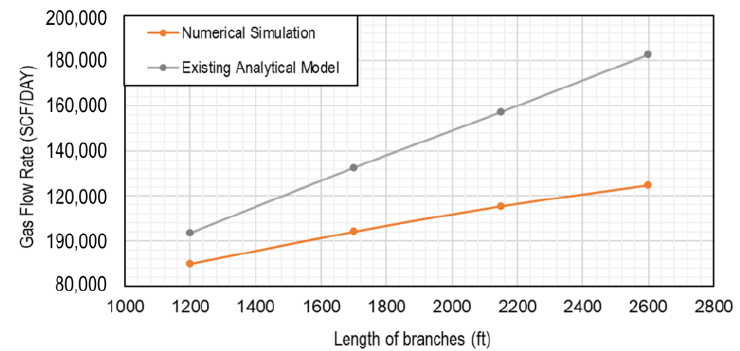
Figure 3. The effect of the length of branches on the cumulative gas production.